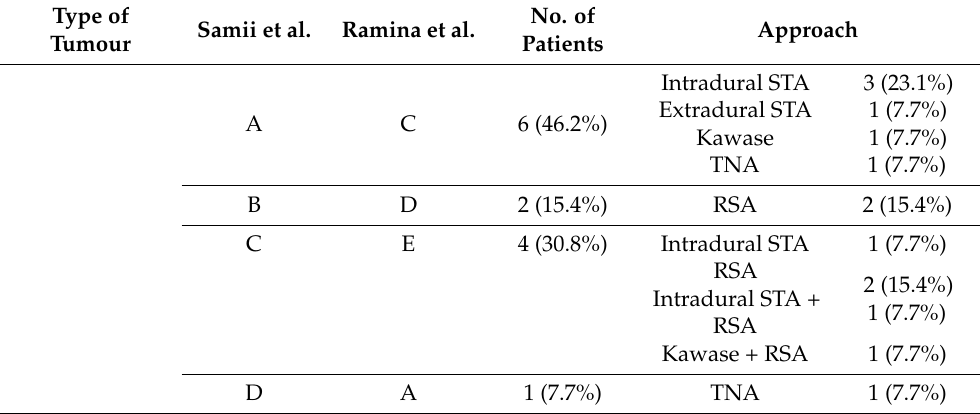
Table 2. Types of tumors and surgical approaches. Data shown as n = number (%). STA = Subtemporal approach. TNA = Transnasal endoscopic approach. RSA = Retrosigmoid